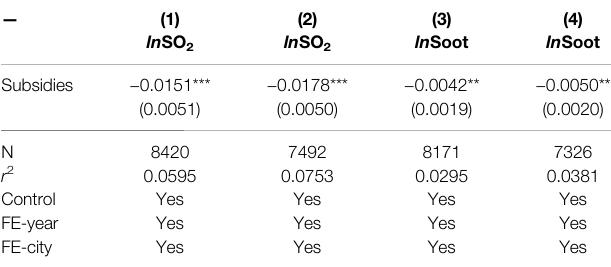
TABLE 2 | Benchmark regression results.